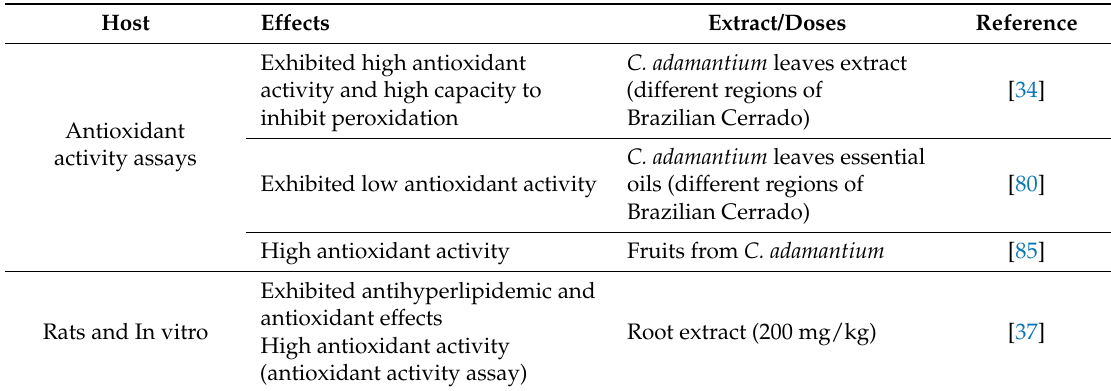
Table 2. Possible effects of C. adamantium in metabolic